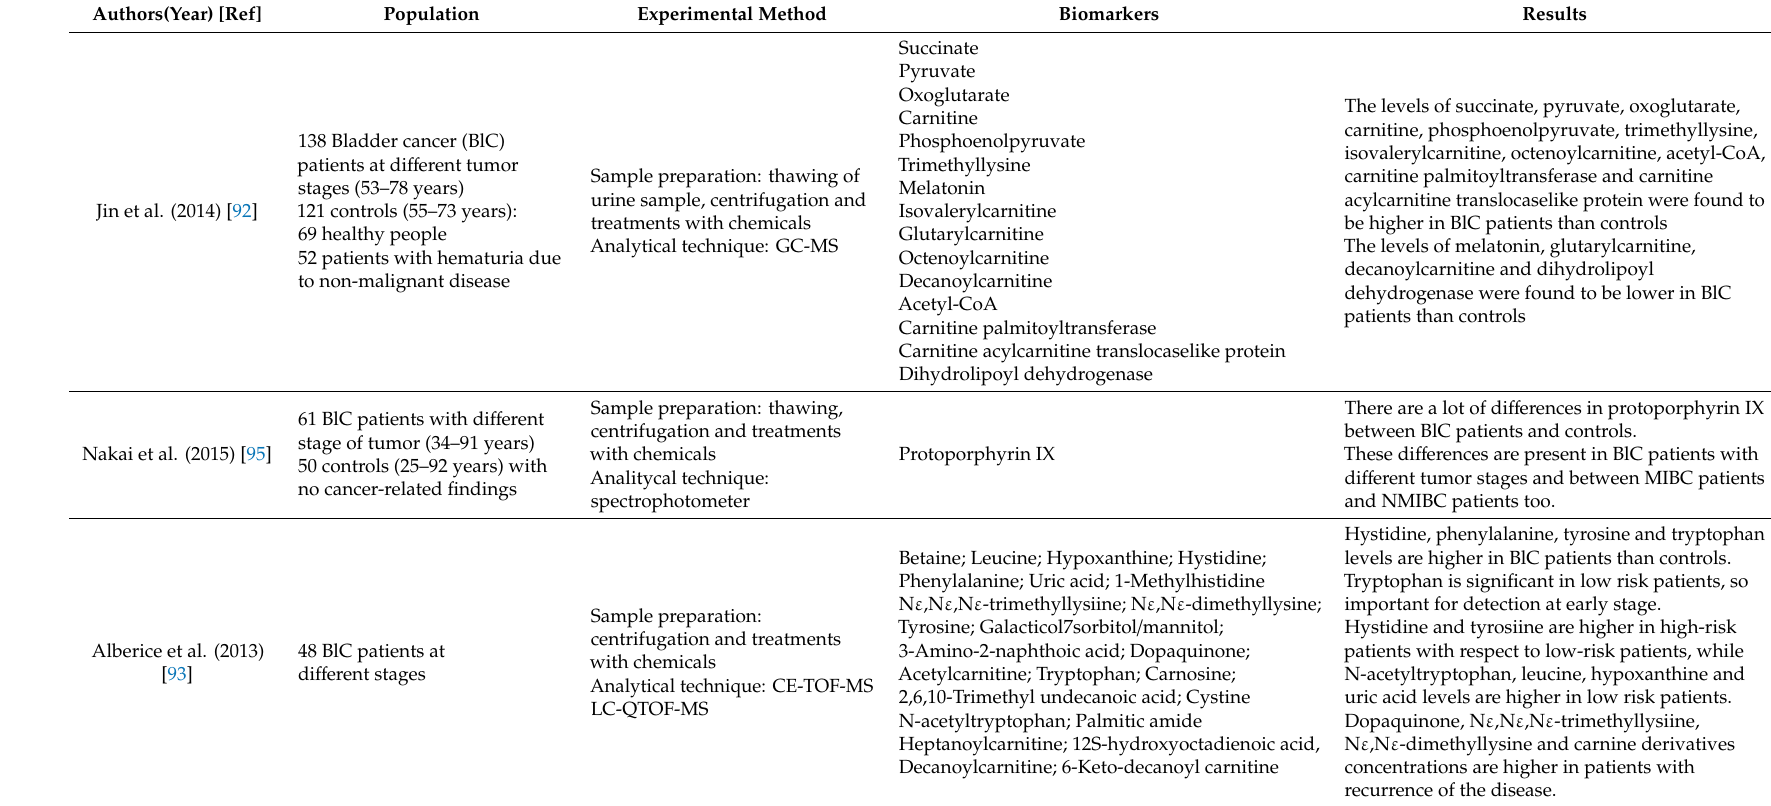
Table 7. Literary studies investigating urinary biomarkers for bladder